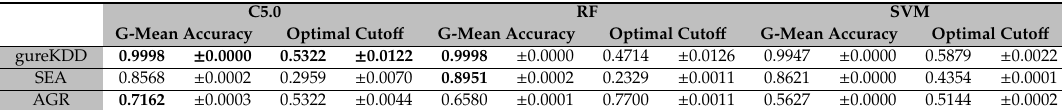
Table 6. Average model accuracy (G-mean accuracy), the average optimal cut-o ff value (at which maximum G-mean accuracy was reached) and their standard deviation of the 10-folds cross-validation (10 repetitions).